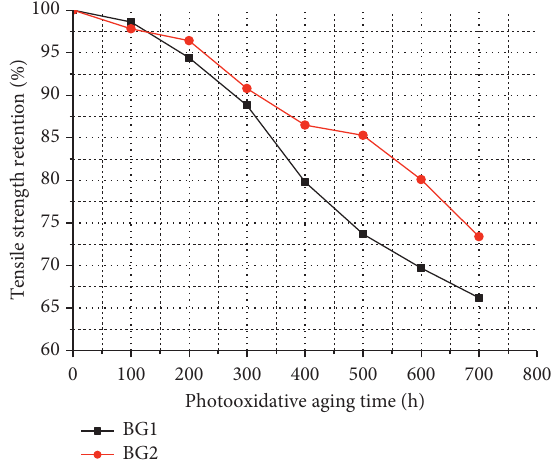
Figure 6: Relationship curves of tensile strength retention rate- photooxidation aging time.